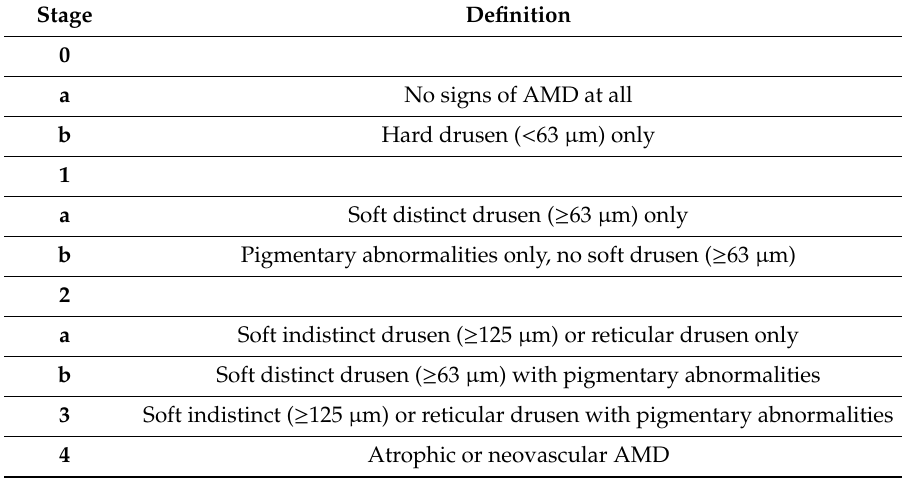
Table 1. Classification of mutually exclusive stages of age-related macular degeneration (AMD) according to the Rotterdam staging